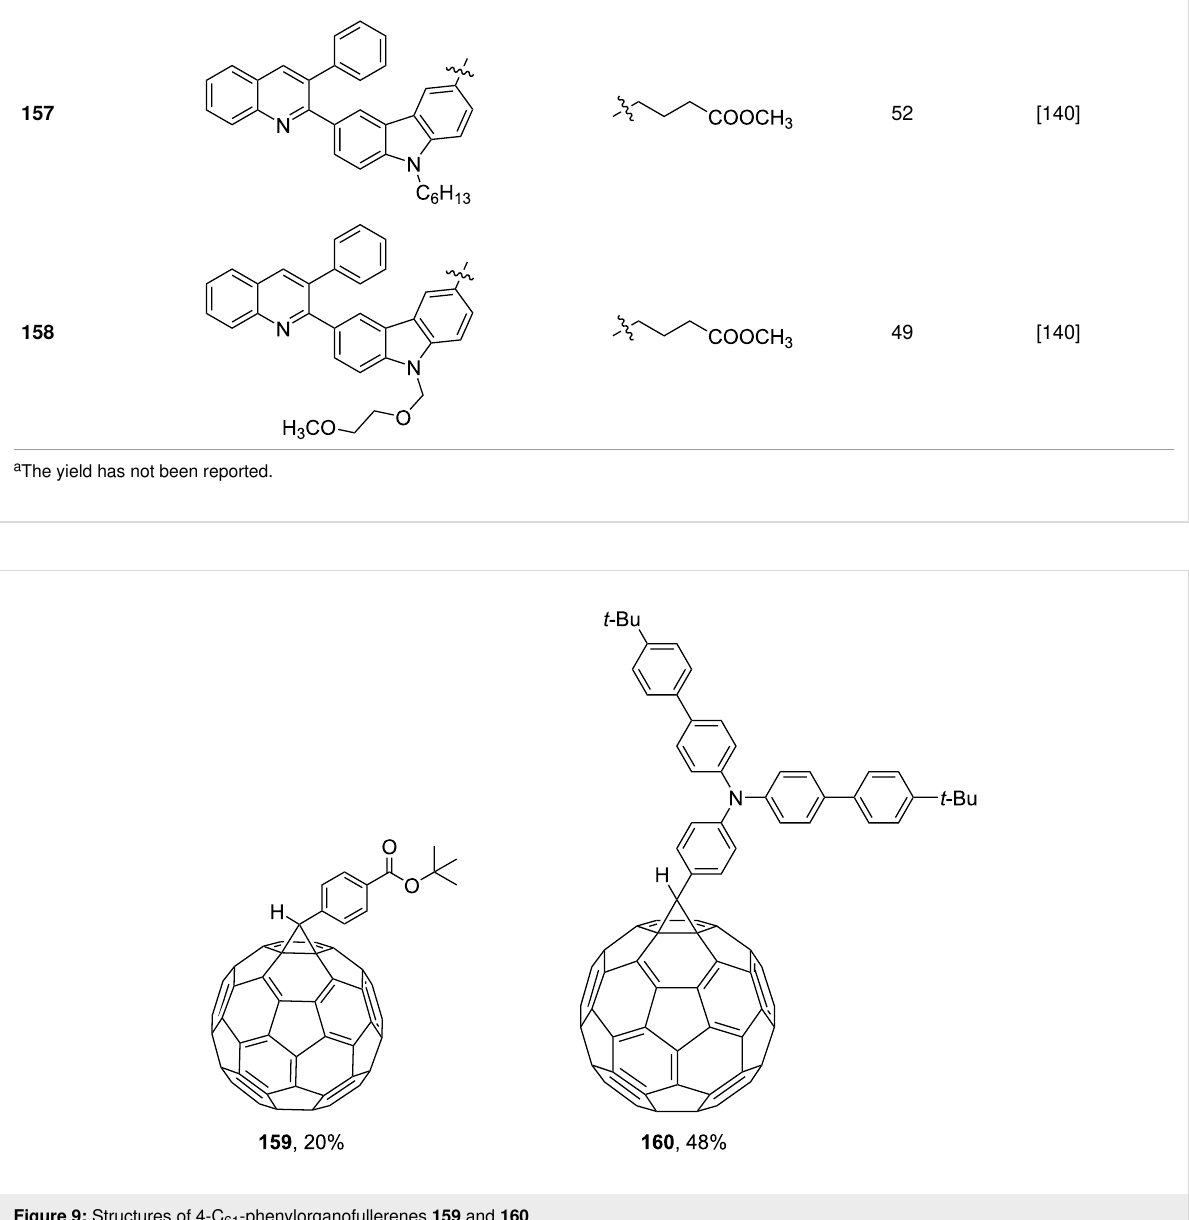
Figure 9: Structures of 4-C 61 -phenylorganofullerenes 159 and 160